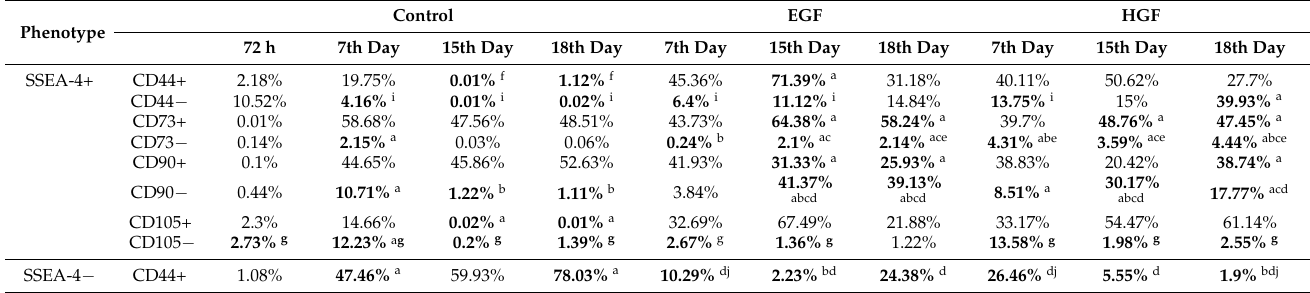
Table 4. Percentage of hAEC cells co-expressing SSEA-4 with mesenchymal markers CD44, CD73, CD90, and CD105 in the control group and differentiated groups (EGF and HGF). Statistically significant differences ( p < 0.05) in relation to group ( a ) control 72 h, ( b ) control 7 days, ( c ) control